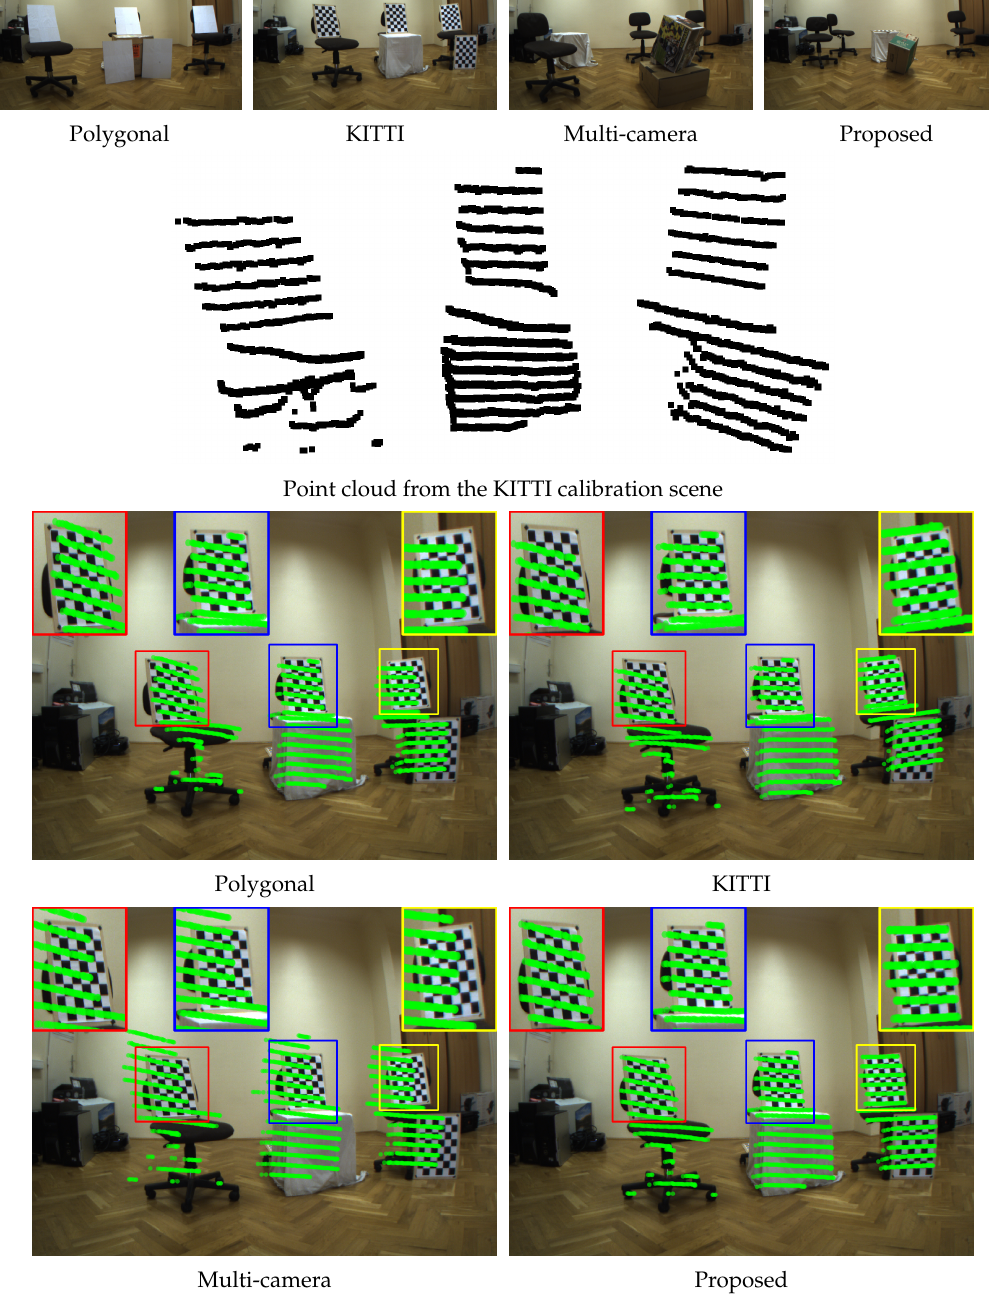
Figure 6. The calibration scenes and re-projections of the methods in the real-world tests. First row: the camera image of the calibration scenes. Second row: the LiDAR point cloud of the foreground objects in the KITTI calibration scene. Bottom row: The re-projections of the previous LiDAR points to the images. The magnified area of the chessboards are shown at the top of the images with the same